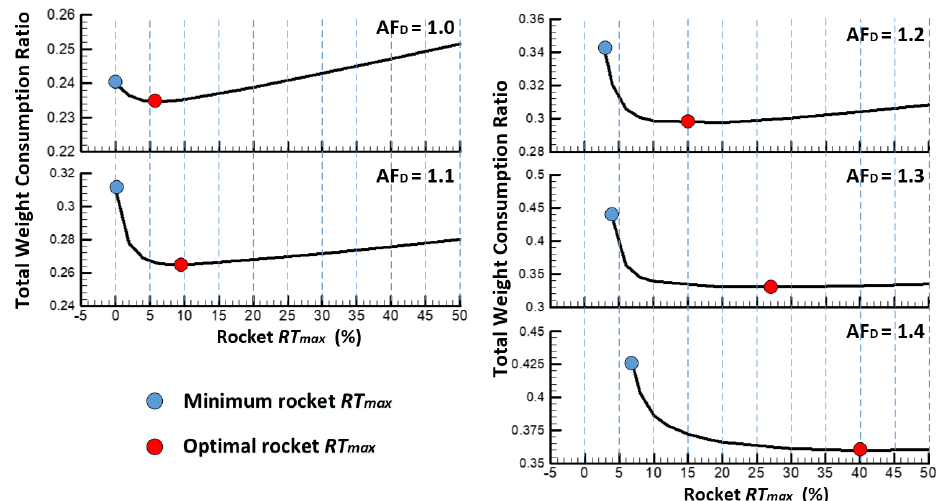
Figure 11. Effect of rocket RT max on total weight consumption under different AF D.